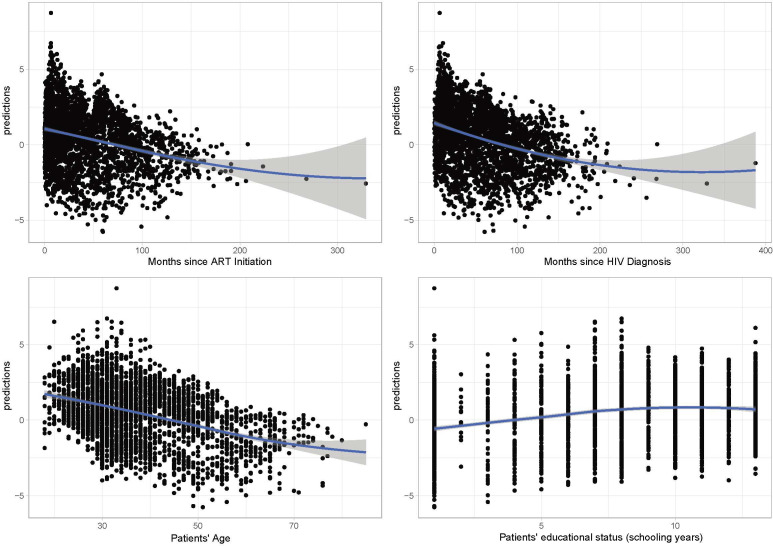
Heterogeneity plots for income-generating time.